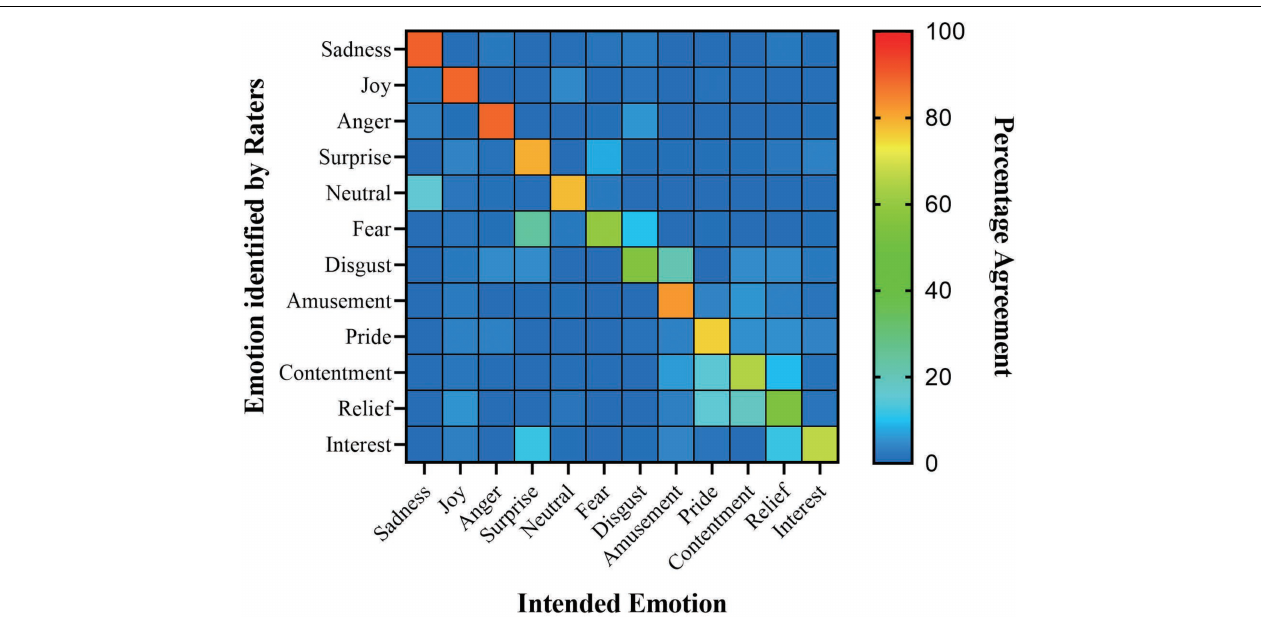
FIGURE 3 | Confusion matrix. Rows represent the emotion identified by raters, and columns represent the designated emotion. The main diagonal shows the degree of agreement between the designated emotion and the raters’ labels, with warmer color representing greater agreement. Off-diagonal entries indicate the confusion across emotions, namely, raters’ misattribution of the intended emotion as a different